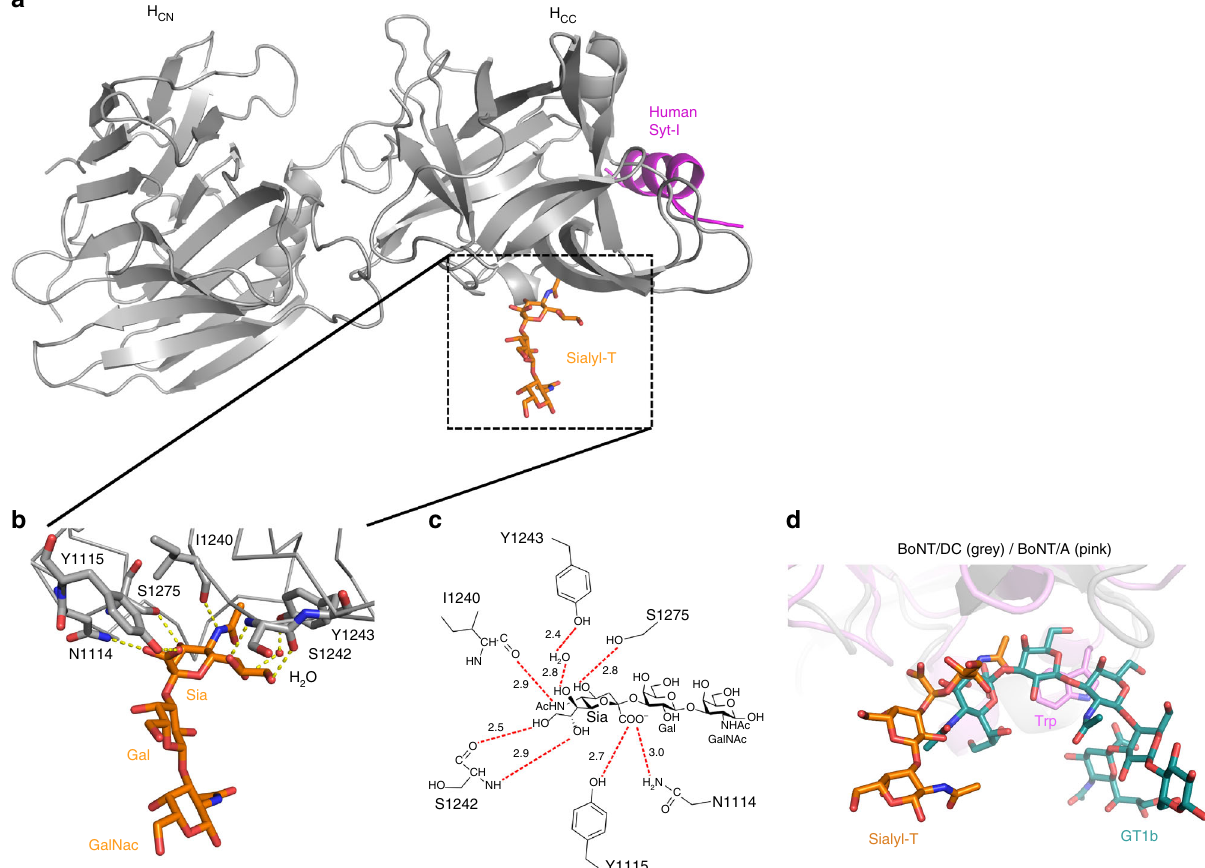
Fig. 4 Co-crystal structure of BoNT/DC-H C in complex with Sialyl-T. a Overall view of BoNT/DC (gray) with the bound Sialyl-T molecule (orange). Human Syt I (magenta) is modeled in from the previously solved structure of BoNT/DC – Syt I complex (PDB code: 4ISQ). b Close-up view of the Sialyl-T binding site of BoNT/DC, with the protein shown in ribbon, Sialyl-T and the interacting residues as sticks, and one interacting water as a red sphere. Possible hydrogen bonds are shown as dashed lines. c Schematic representation of the possible hydrogen bonds between Sialyl-T and BoNT/DC (red dashed lines). The distance for each bond is shown in Å. d Structural comparison between BoNT/A and BoNT/DC on ganglioside binding. The Sialyl-T binding site in BoNT/DC (shown in gray) is located at a position similar to the GBS in BoNT/A (shown in pink). The sialic acid (Sia) of Sialyl-T (shown in orange) sits in a similar position as the Sia5 group of the GT1b (shown in cyan) bound to BoNT/A. The rest of the Sialyl-T carbohydrates are at a different position than the Gal4-GalNAc3 moieties in GT1b, which form both hydrogen bonds and stacking interactions to a Trp residue in the GBS of